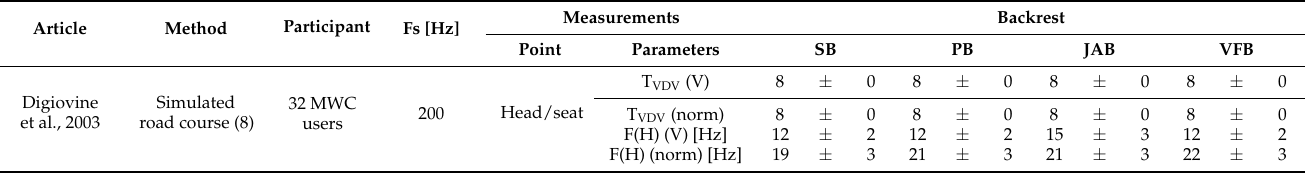
Table 10. Summary table of reviewed studies regarding the effects of backrest on vibration